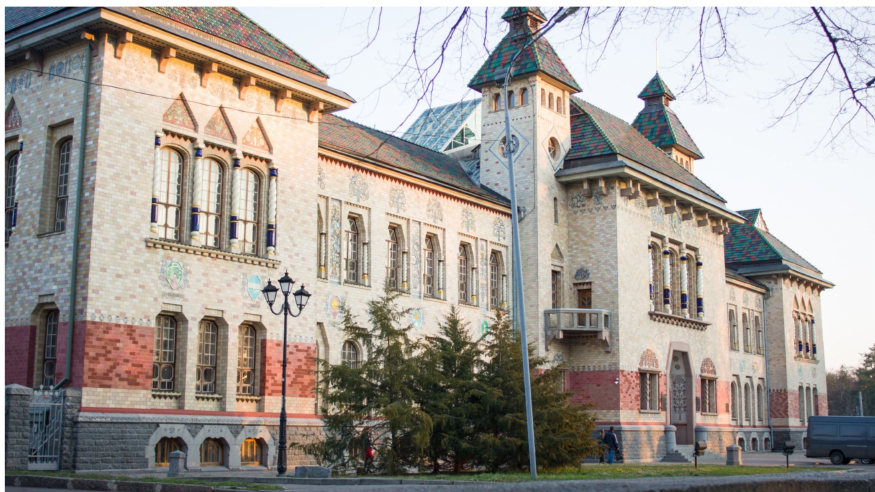
Figure 2. General view of the building (source: authors).